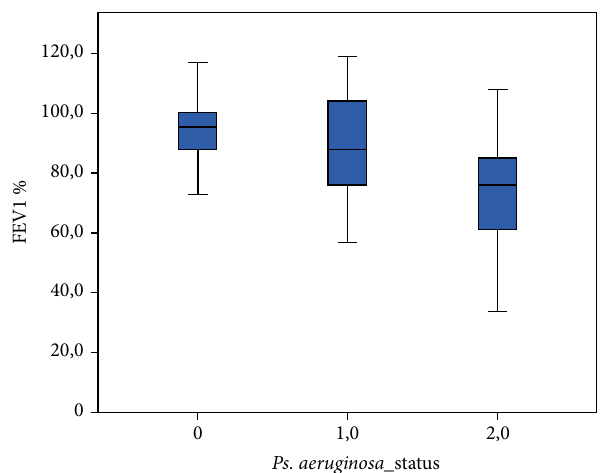
Figure 1: FEV1% predicted among the three groups of patients. (0: patients not colonized, 1: patients intermittently colonized with P. aeruginosa , 2: patients chronically colonized with P. aeruginosa ).